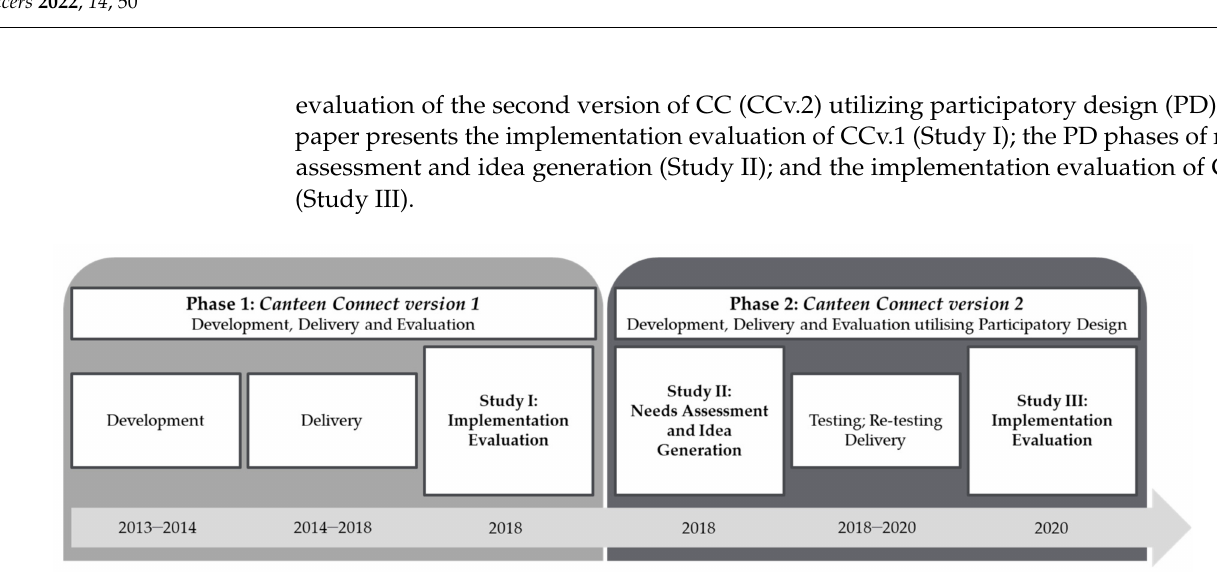
Figure 1. Components of the development, delivery, and evaluation of Canteen